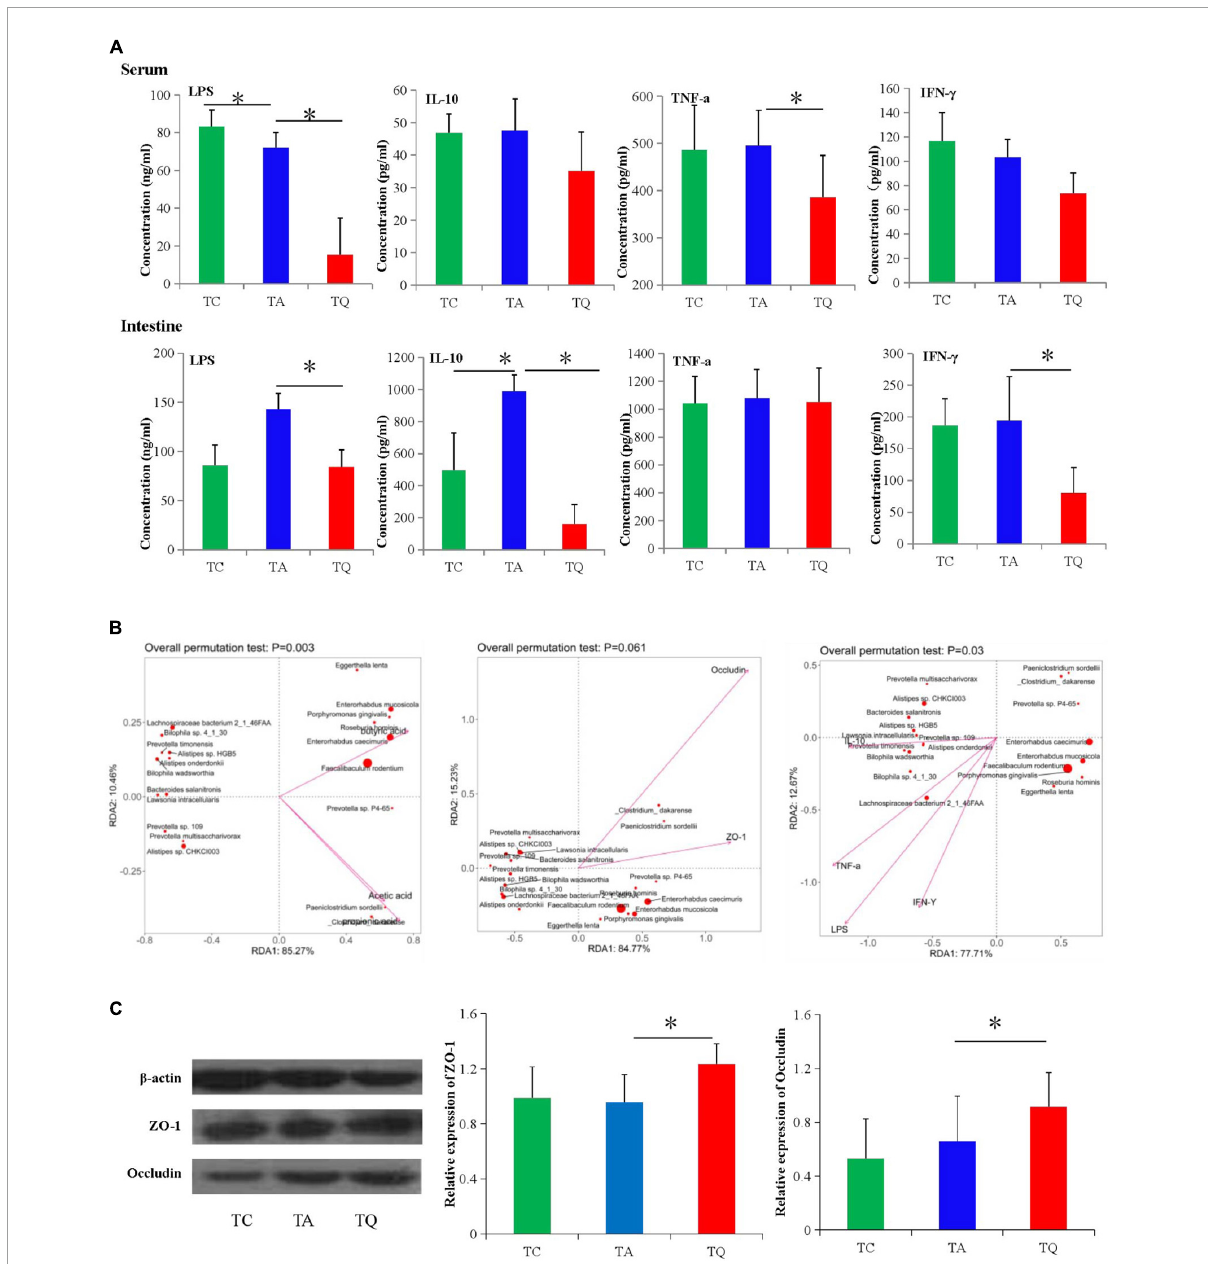
FIGURE7 Gut microbial metabolites and gut barrier functional test. (A) Serum and intestinal inflammatory index concentration in different groups, ∗ P < 0.05. (B) Spearman correlation analysis between significantly different bacteria species and gut barrier indexes. (C) Intestinal tight junction proteins (ZO-1 and Occludin) expression test followed by western blot analysis, ∗ P <